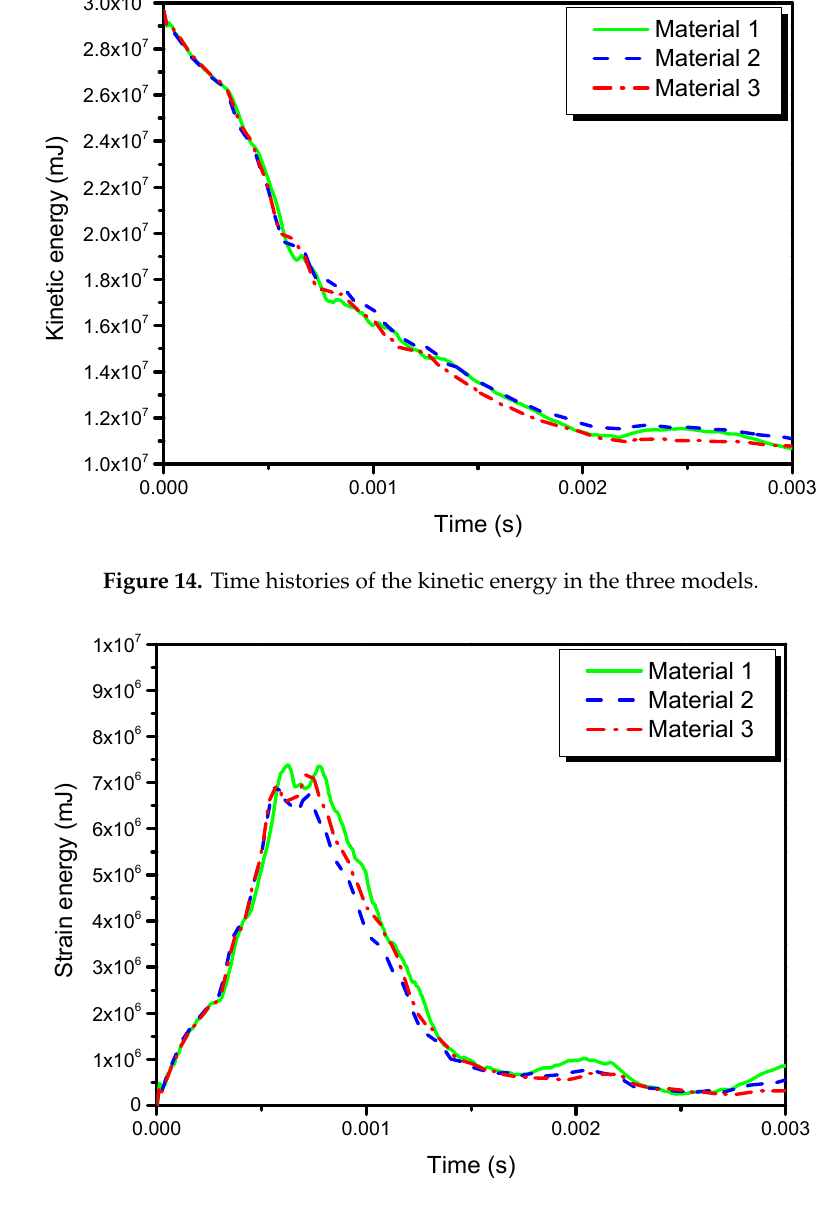
Figure 15. Time histories of the strain energy in the three models.